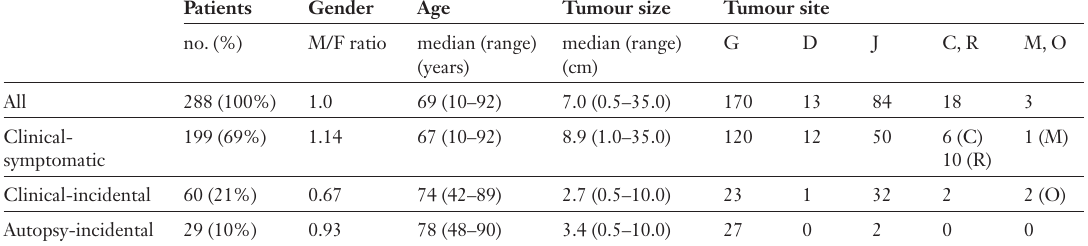
Clinical presentation of GIST in the pre- imatinib era accord- ing to a population- based study in Swe- den [data from 17] (G, stomach; D, duo- denum; J, jejunum- ileum; C, colon; R, rectum; M, mesen- terium; O,